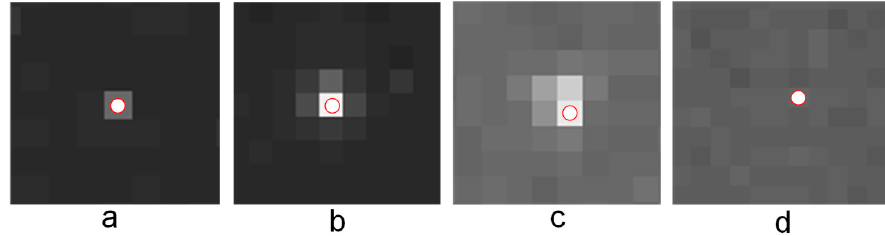
Figure 6. Filter template processing.